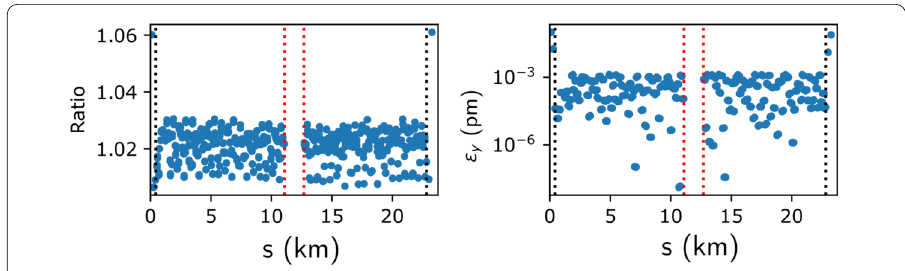
Figure 7 Ratio between vertical emittance from analytical expression and the MAD-X calculation of the vertical emittance (left) and absolute value of vertical emittance from analytical expression for 10 μ m alignment errors on single sextupoles in the FCC-ee. The interface between the arc and IRs, and the arc and RF insertion are indicated in black and red respectively